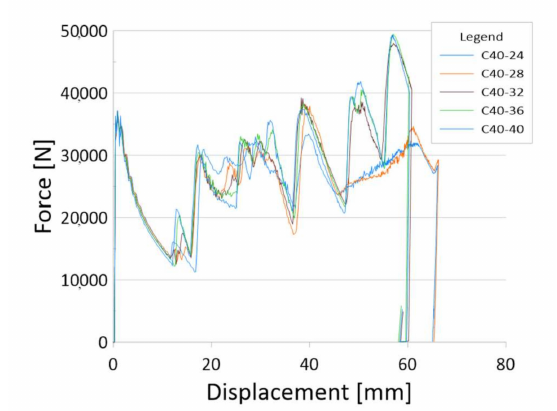
Figure 10. The results for models with a sidewall thickness of 1–3 mm.